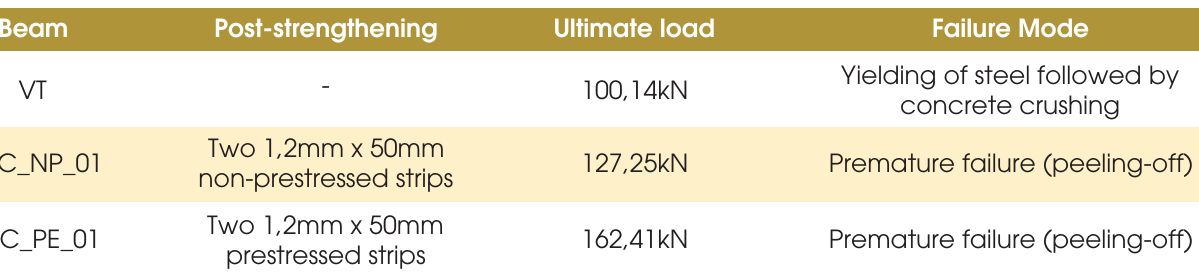
Table 3 – Ultimate Loads and failure modes of post-strengthened beams tested under static loading Beam